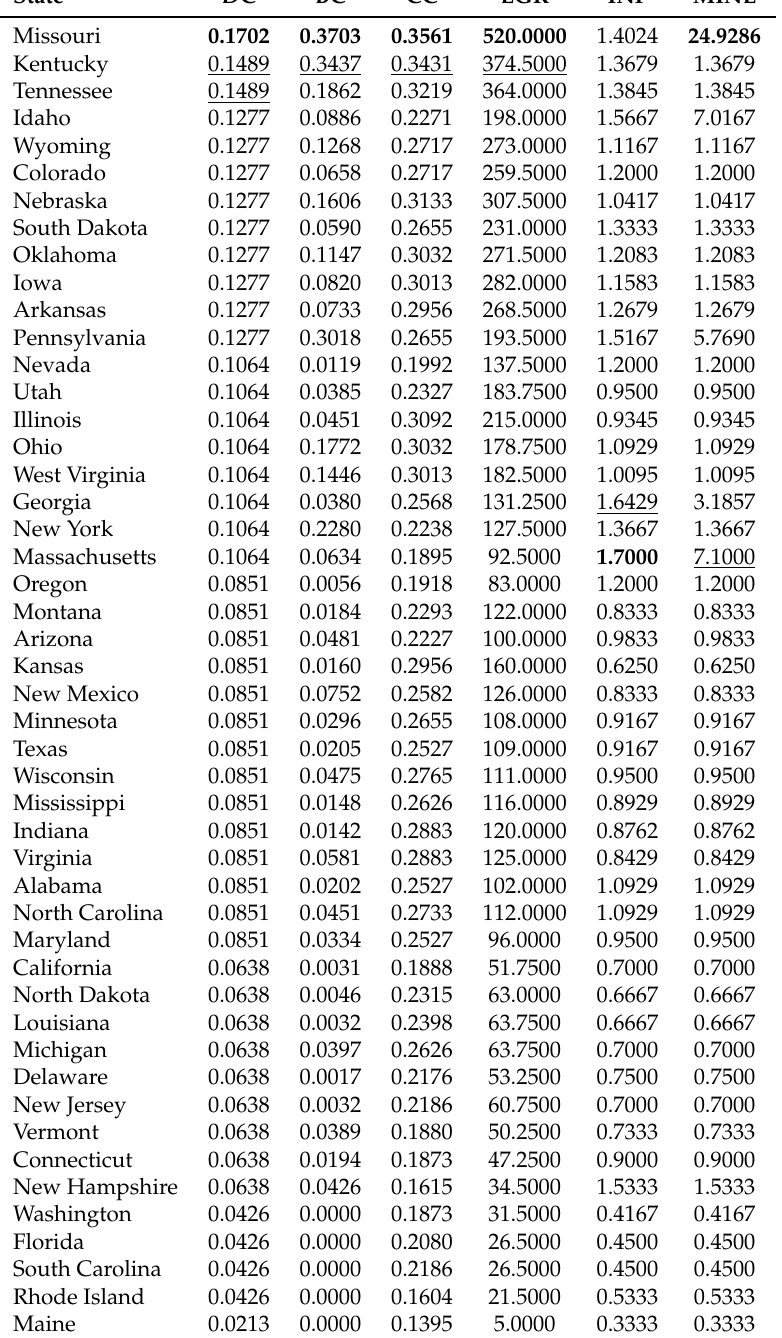
Table 6. Comparison of the lower 48 United States, measured by DC, BC, CC, LGR, INF and